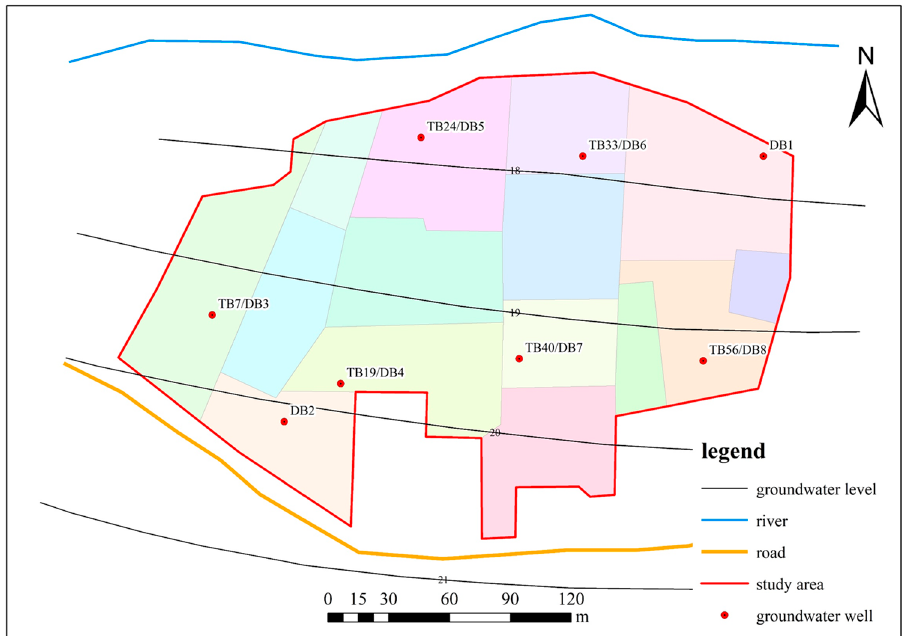
Figure 6. Groundwater flow-field map in the study area.